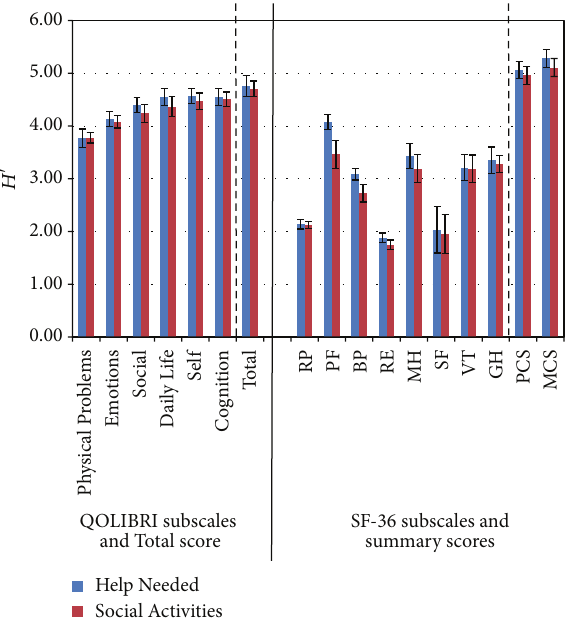
Figure 2: Shannon indices 𝐻 󸀠 (confidence intervals 95%) of all QOLIBRI and SF-36 subscales, QOLIBRI Total score and MCS and PCS for the correlates: Help Needed and Social Activities.